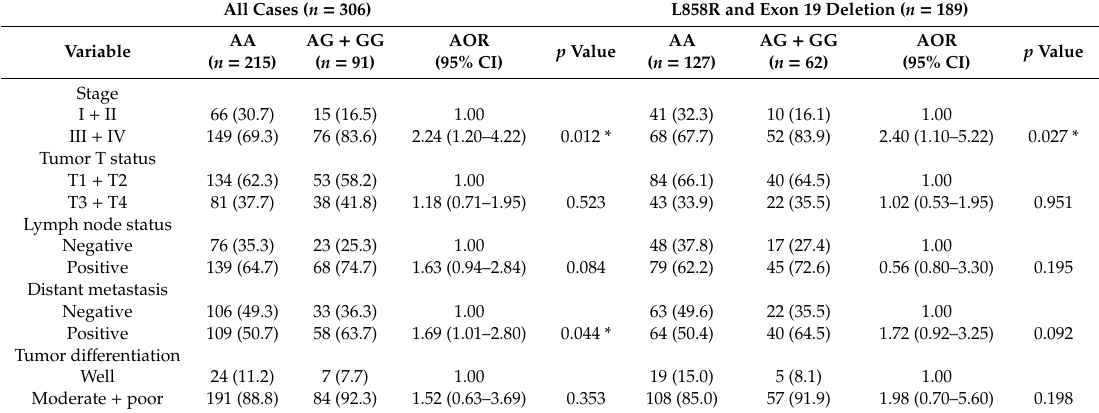
Table 4. Clinicopathologic characteristics of lung adenocarcinoma patients with EGFR mutation, stratified by polymorphic genotypes of SOD rs4880.